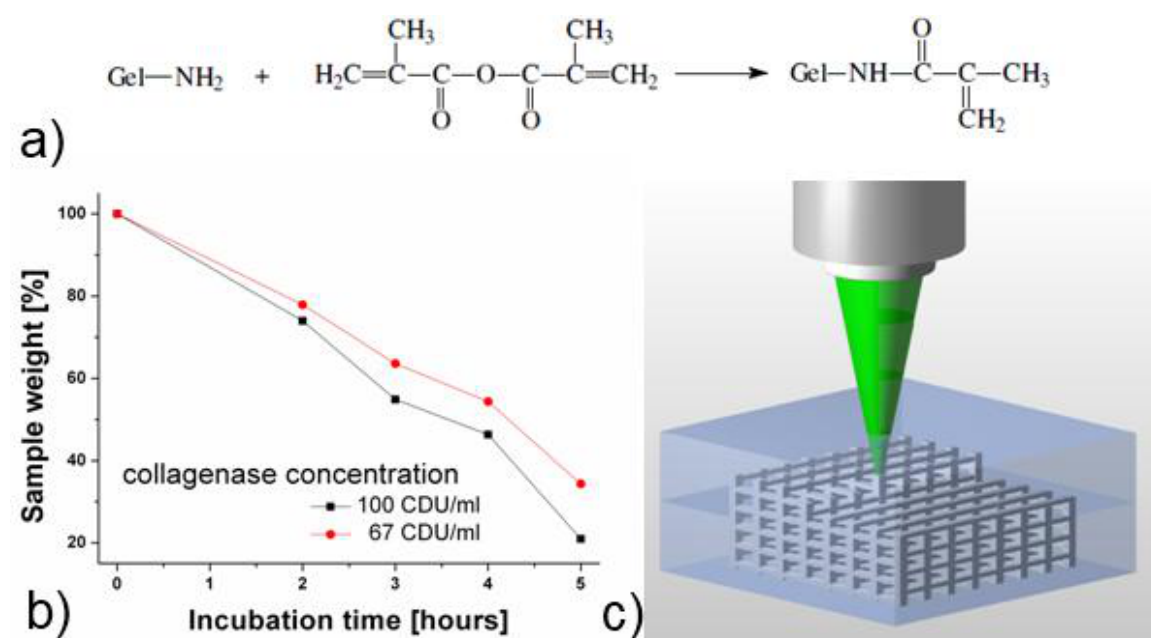
Figure 1. ( a ) Overview of the synthesis of methacrylamide- modified gelatin